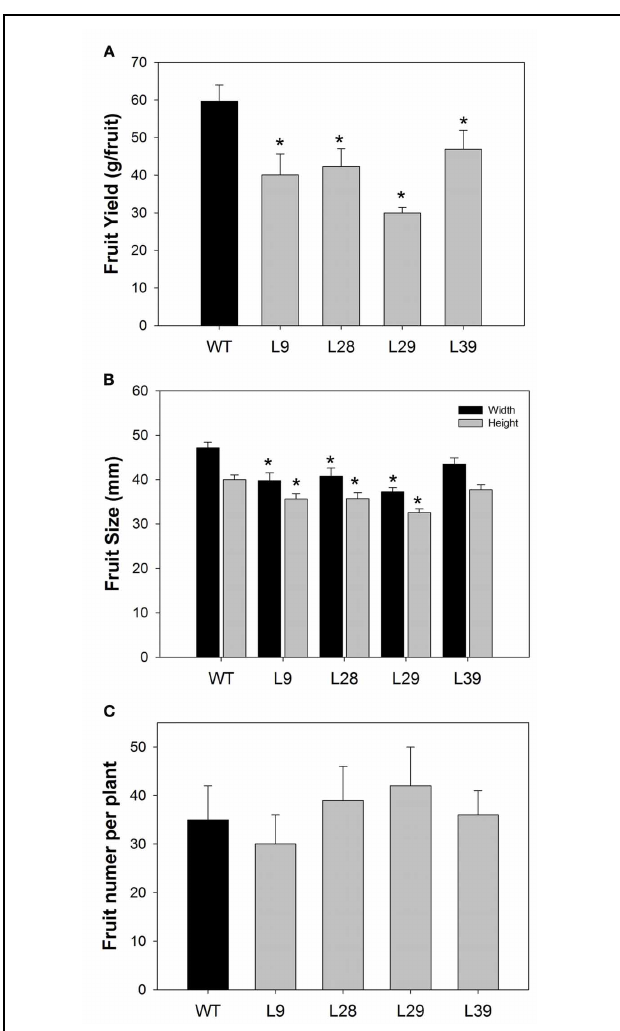
FIGURE 2 | Characterization of B33-PPi tomato lines. (A) Fruit yield (g per fruit), (B) fruit size, and (C) total fruit number of B33-PPi lines. All measurements were done in red stage (60 DAP). For all parameters, values are presented as the mean ± SE of eight biological replicates (one biological replicate is represented by one individual plant). An asterisk indicates the values that were determined by the t- test to be significantly different ( P < 0 . 05) from wild type.